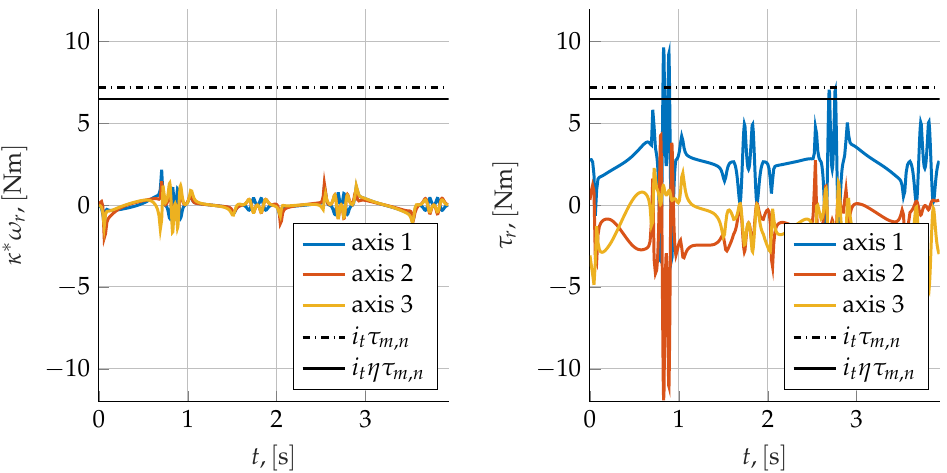
Figure 21. Torques at the output shaft for i t = 9; in the left panel : inertial torques of the motor projected through an ideal transmission; in the right panel the load torques are reported. The black lines represent the rated torque of the motor reduced to the output shaft through an ideal (dashed line) and non-ideal (continuous line) transmission.